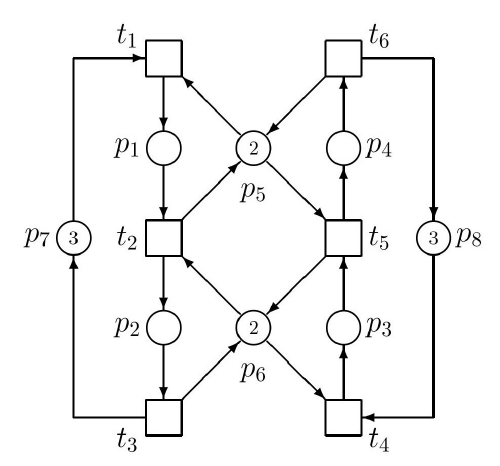
Figure 1. The PN model of an